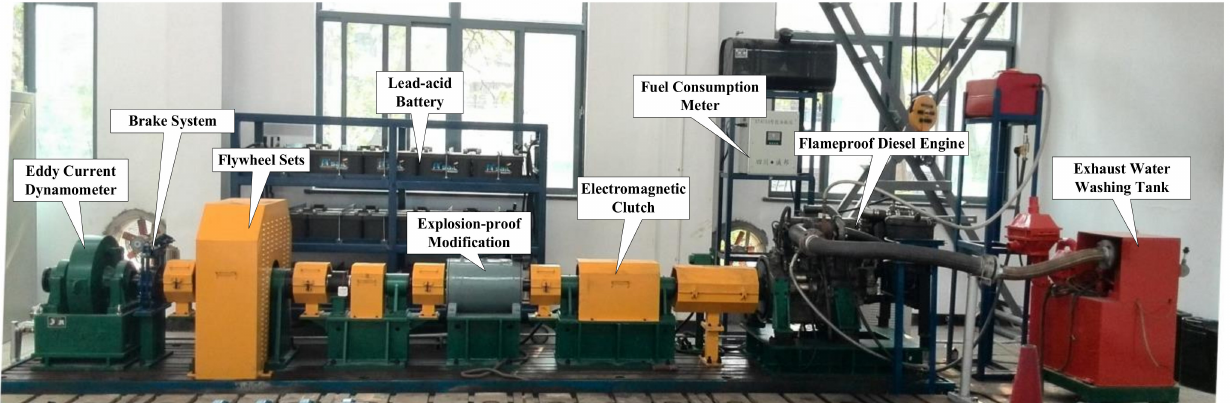
Figure 2. Hybrid test bench for